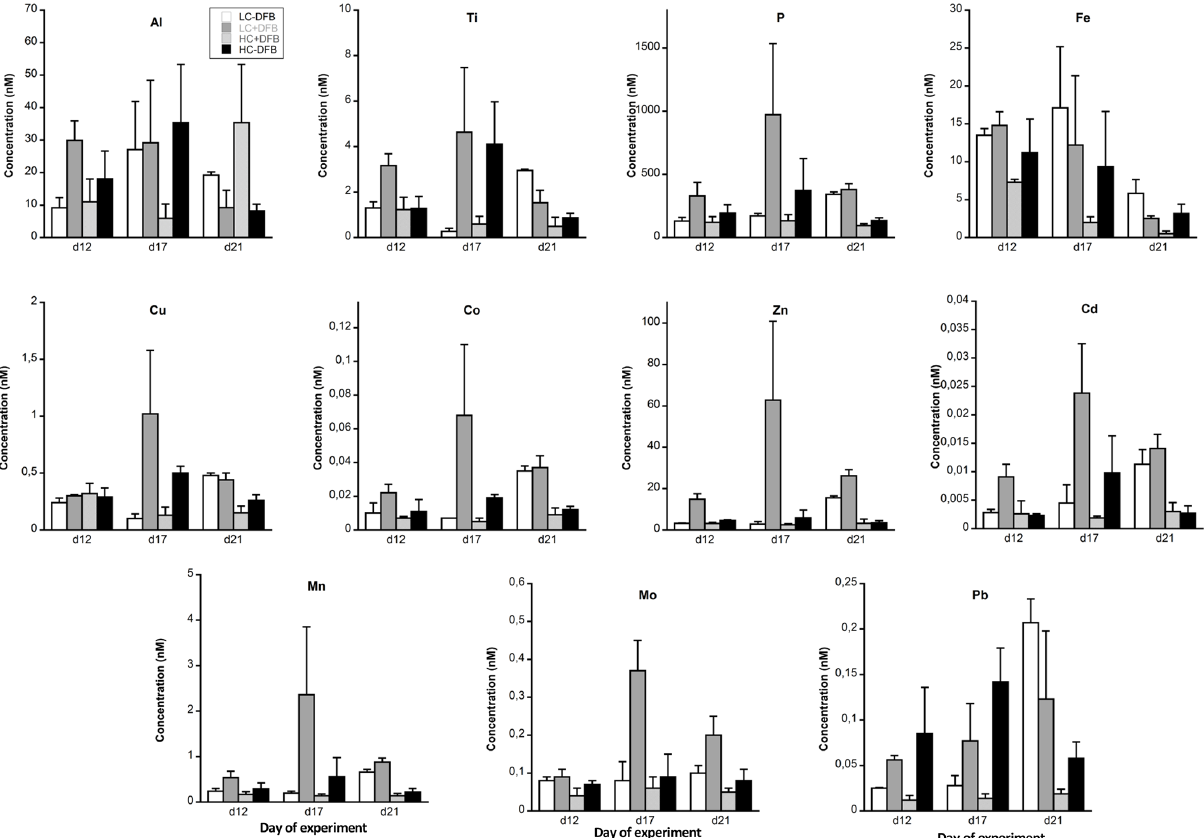
Figure 1. The concentration of particulate metals in seawater (nM) in the different treatments. LC: ambient CO 2 (390µatm); HC: increased CO 2 (900µatm). -DFB and +DFB are the ambient dFe and increased dFe, respectively, during the development of a bloom of Emiliania huxleyi . Bars are means of measurements in three independent mesocosms ( n = 3) except for LC-DFB where n = 2. Error bars indicate SD.